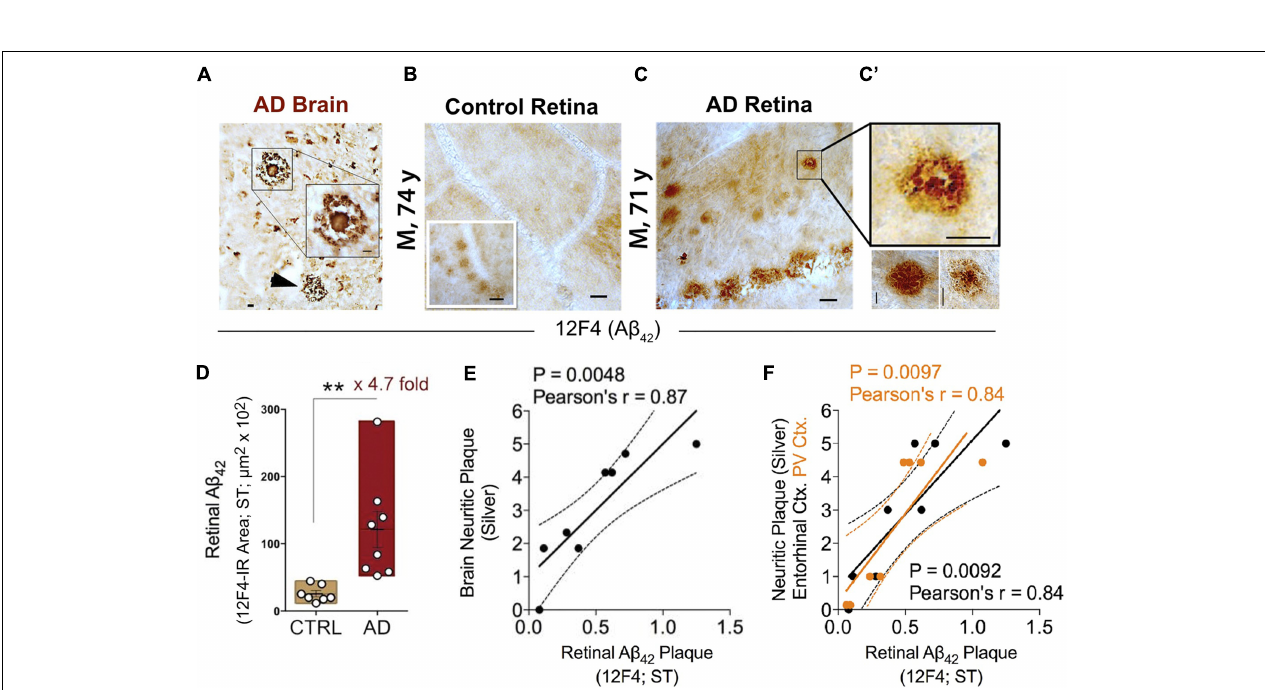
FIGURE 2 | Increased retinal A β 42 deposition correlates with cerebral amyloid plaque burden in Alzheimer’s patients. (A) Representative micrographs from an AD brain and (B) flat-mount retinas from a cognitively normal (CN) subject and (C) AD patient stained with anti-A β 42 mAb (12F4). Although smaller in size, retinal A β plaques are similar in morphology to brain plaques. Scale bar: 20 µ m. (C) High-magnification images reveal diffuse, compact, and “classical” mature plaque morphology of retinal A β aggregates. Scale bar: 10 µ m. (D) Quantitation of retinal A β 42 plaque burden, measured by 12F4 immunoreactive area, in AD patients ( n = 8) and sex-/age-matched CN control subjects ( n = 7). Data shown as group mean ± SEM. ** P < 0.01, unpaired 2-tailed Student’s t -test. (E,F) Pearson’s correlation coefficient tests between retinal A β 42 plaque load (12F4-immunoreactivity) and mean cerebral neuritic plaque burden (e; r = 0.87, P = 0.0048, n = 8; severity score of Gallyas silver staining) or regional plaque burden either in the entorhinal ( F ; black symbols; r = 0.84, P = 0.0092, n = 8) or primary visual cortex ( F ; orange symbols; r = 0.84, P = 0.0097, n = 8). Reproduced from Koronyo et al. (2017) with permission of ASCI via Copyright Clearance Center.